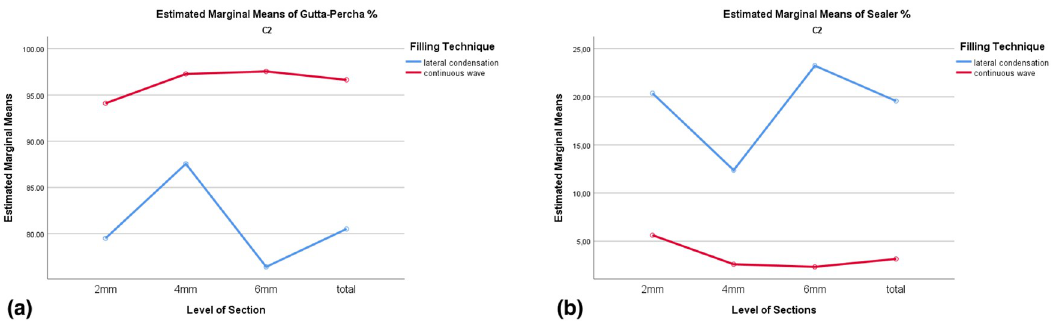
Fig 8. Interaction effects of filling techniques and level of sections on (A)gutta-percha (B)sealer percentages in C2-type.